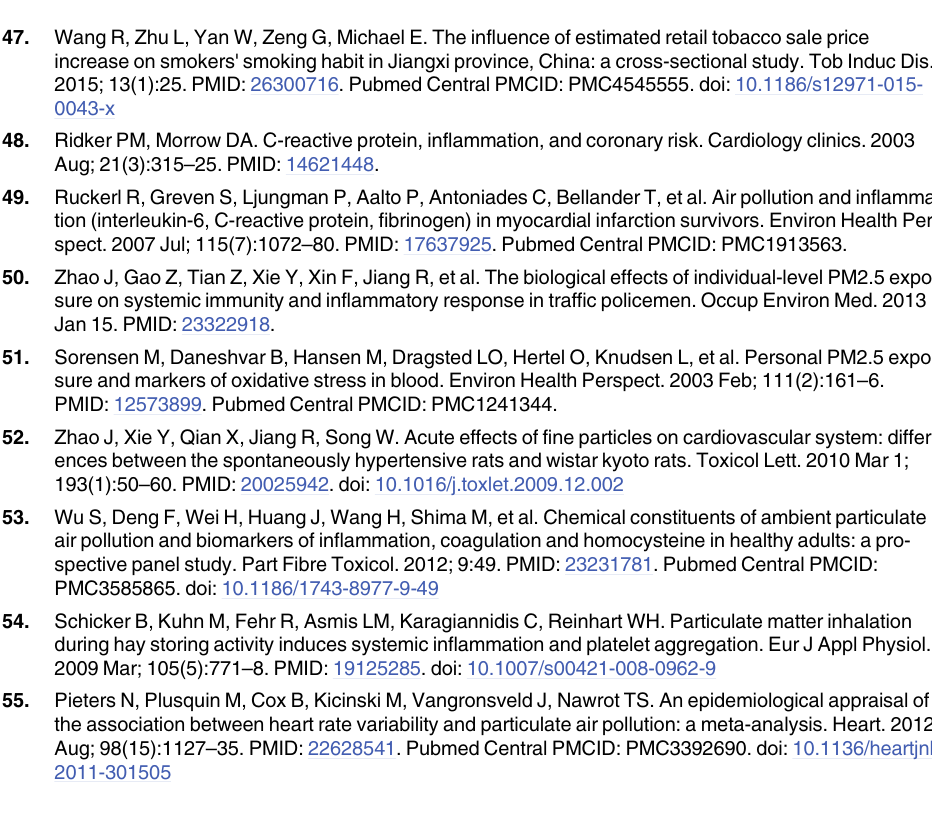
PLOS ONE | DOI:10.1371/journal.pone.0151119 March 4,